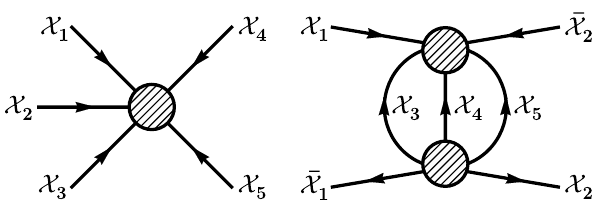
Figure 1 . The Feynman diagrams of the 3 → 2 and the two-loop induced 2 → 2 processes in the r SIMP scenario, where X denotes the SIMP particle and the arrow represents the dark charge i